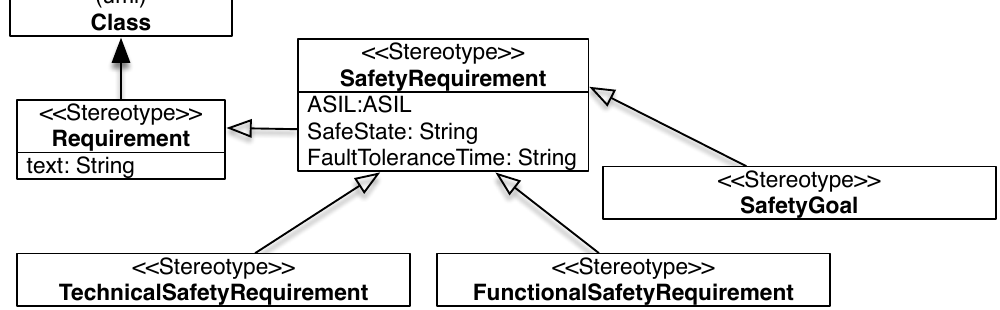
Figure 3. Requirements based on